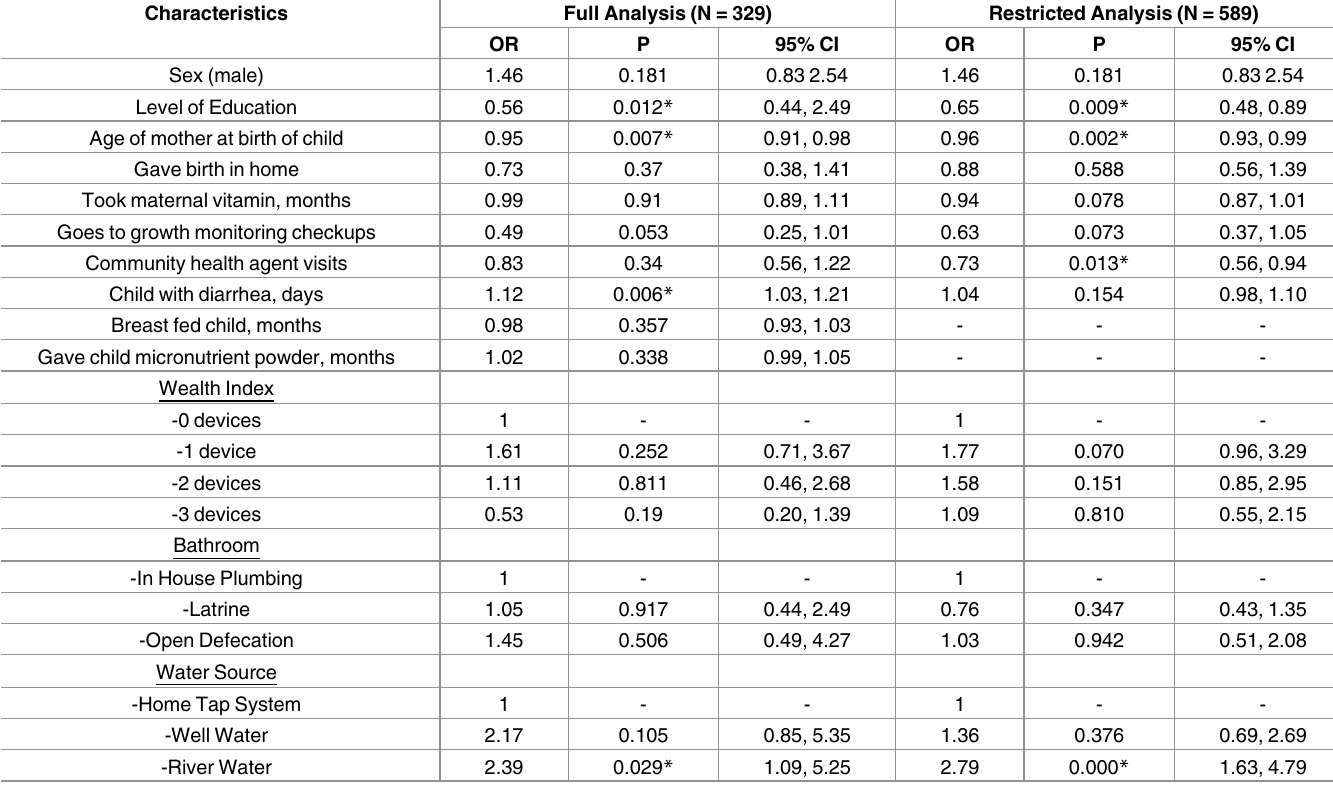
Table 3. Logit regression: Association and odds ratio between developmental delay and each social determinant.